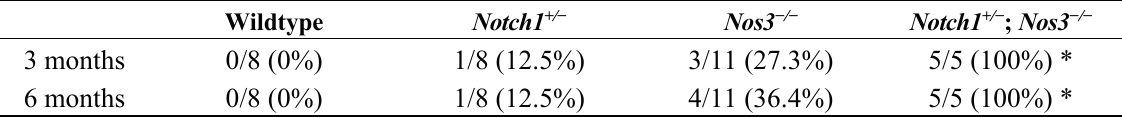
Table 1. Effacement of Sinotubular Junction by Genotype. Fraction of mice with STJ effacement is shown at 3 and 6 months of age, * p value